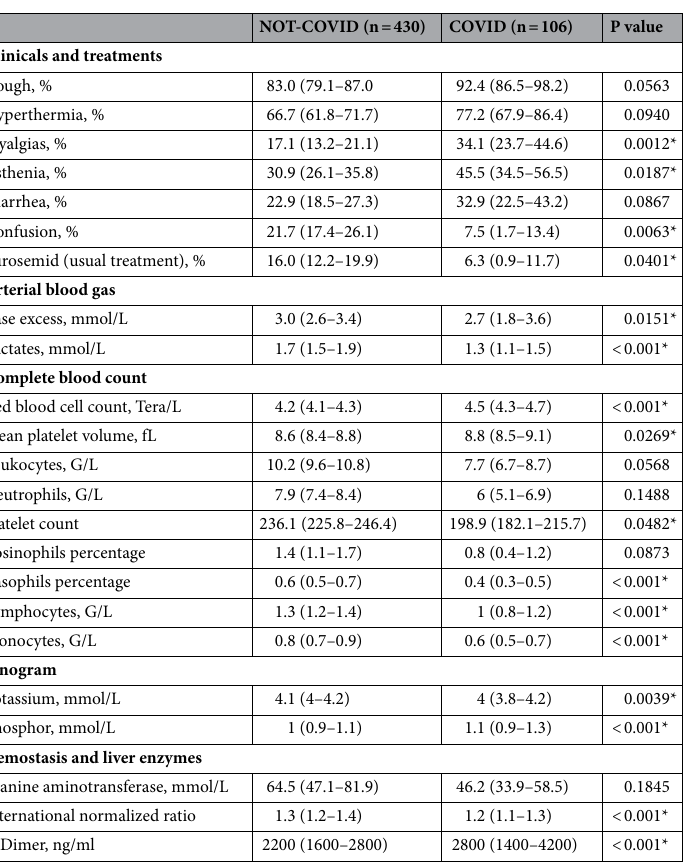
Table 2. Variables of interest. Means and percentage between groups were compared with Student’s t- and chi- square tests, respectively. Only variables with p < 0.02 were considered as variables of interest and were listed in this table. Values in brackets represent the 95% confidence intervals. *p <